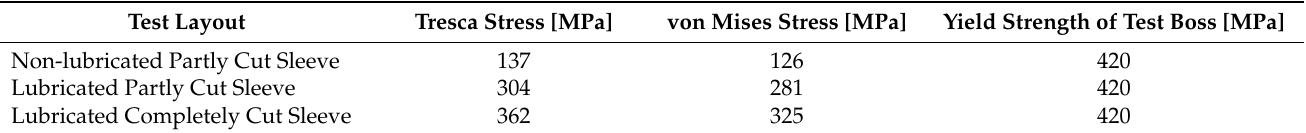
Table 4. Evaluation of failure (yield criteria) based on measured